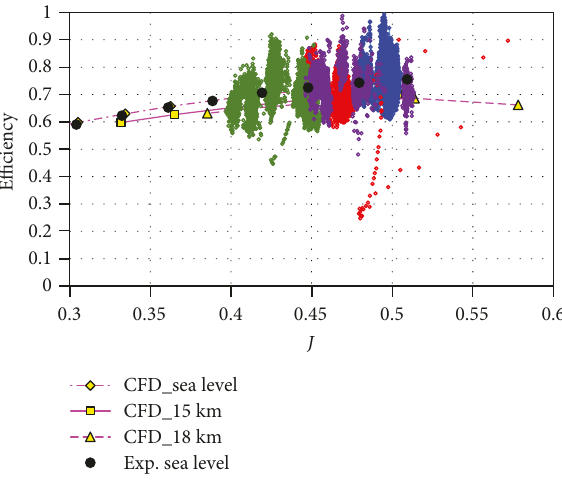
Figure 28: Comparison of thrust coe ffi cient